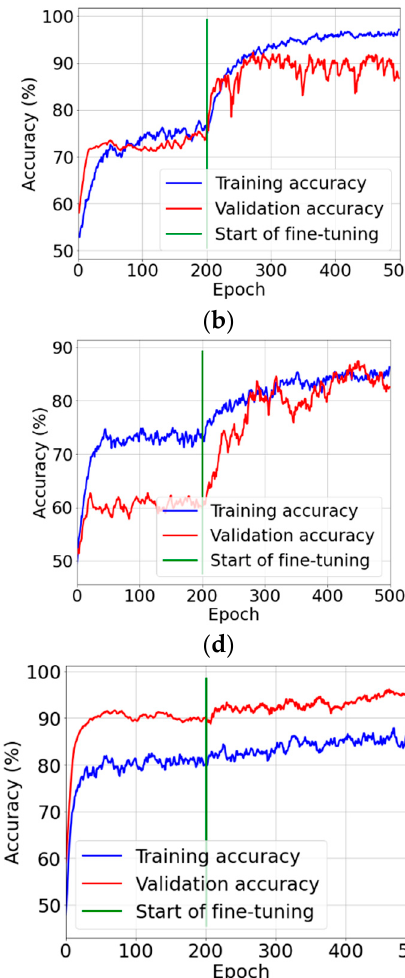
Figure 11. Plots of the training and validation accuracy during the stages of feature extraction and fine tuning: ( a ) VGG16; ( b ) VGG19; ( c ) MobileNetV2; ( d ) Xception; ( e ) ResNet50; and ( f ) Inception- ResNetV2.